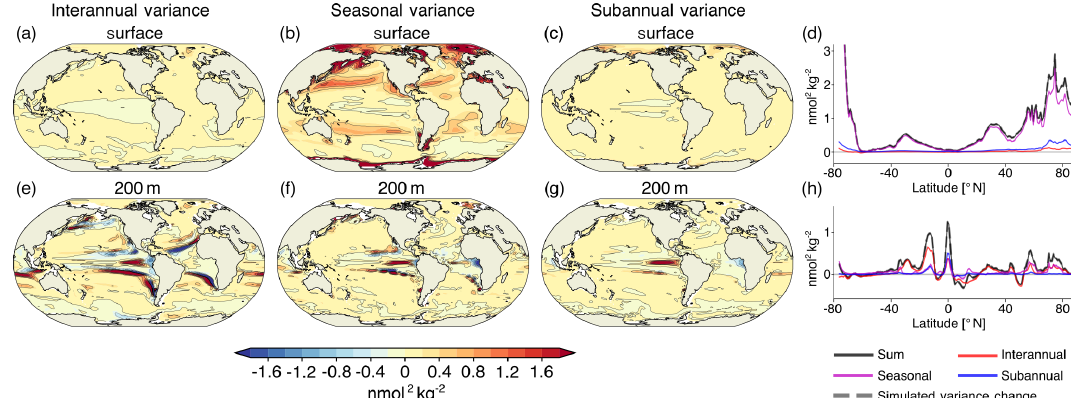
Figure 8. Contribution to projected changes in [H + ] variance from interannual variability (a, e) , seasonal variability (b, f) , and subannual variability (c, g) between the preindustrial period and the 2081–2100 period under the RCP8.5 forcing at the surface (a–d) and at 200m (e–h) . Shown are the ensemble-mean changes. The black lines highlight the pattern structure. Zonal mean contributions are shown for the surface (d) and for 200m (h) . The sum of the three components (black lines) accurately reproduces the simulated variance change (gray dashed